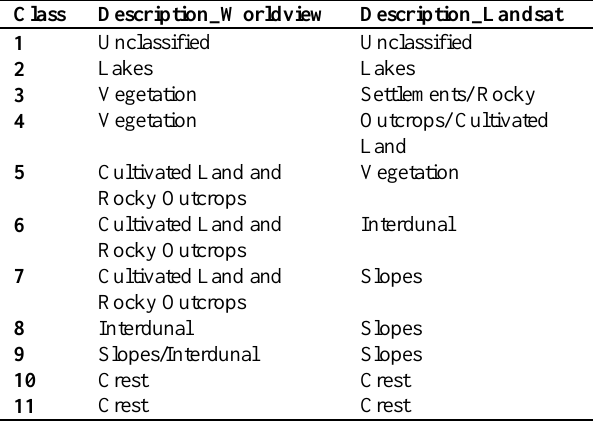
Table 6: K-Means Classification classes and respective features for Worldview.